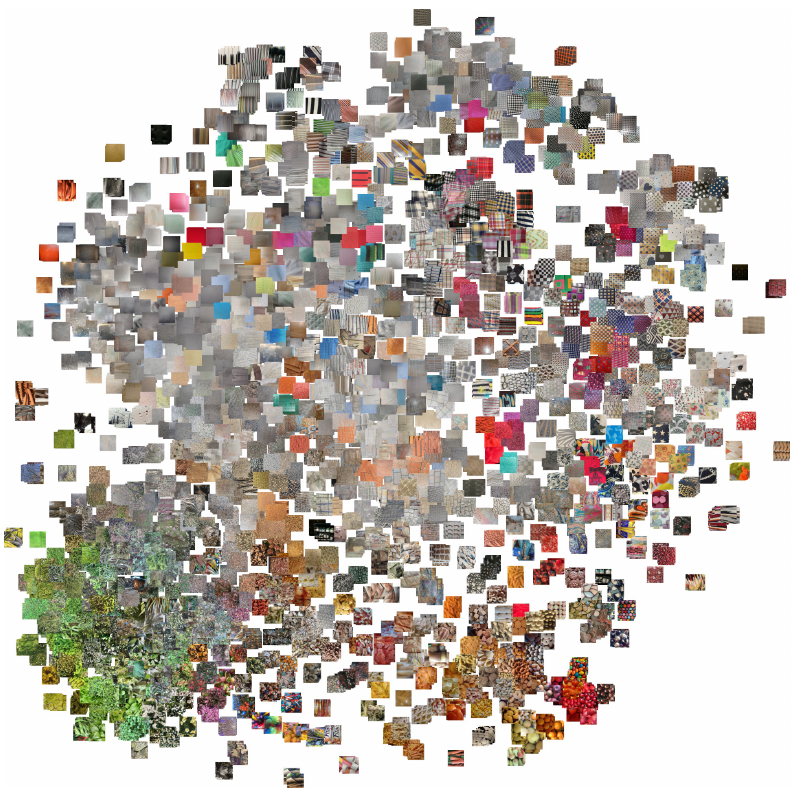
Figure 6. Result of the application of t-SNE to the features extracted by a Resnet50 CNN trained on ILSVRC